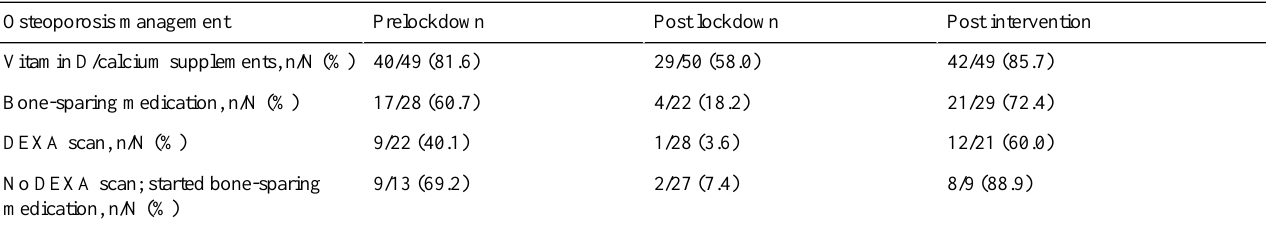
Table 4. Patients who received the correct osteoporosis management procedures during the 3 phases. The patients who met the criteria for a DEXA (dual energy X-ray absorptiometry) scan but were treated with bone-sparing medications instead are also represented.